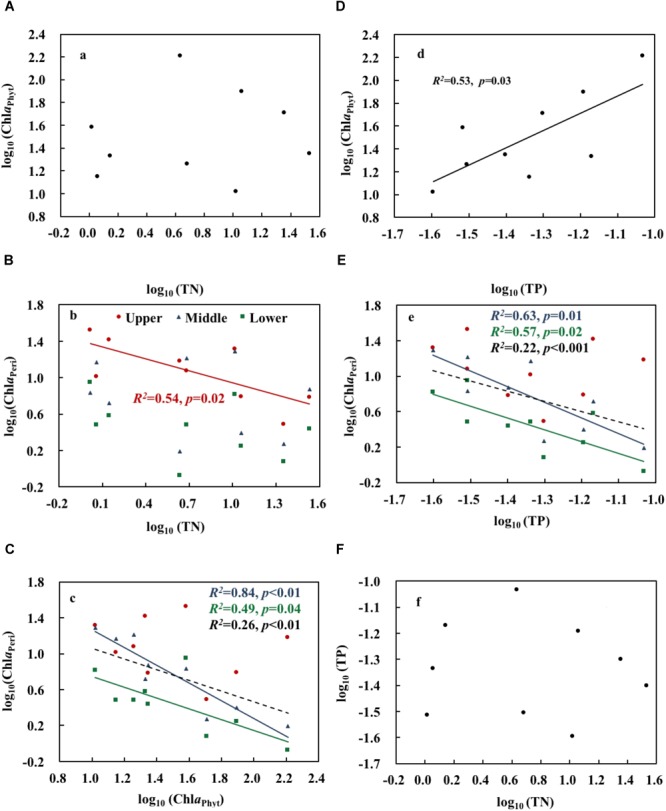
Relationships between total nitrogen, total phosphorus, phytoplankton chlorophyll a, and periphyton chlorophyll a
(A–F). Upper, middle, and lower represent the layer at 0.4, 0.8, and 1.2 m below the water surface (n = 9). The dotted line shows significant relationships of pooled data from all depths (n = 9). The red, blue, green, and black R2 and p correspond to the red, blue, green, and black line, respectively.